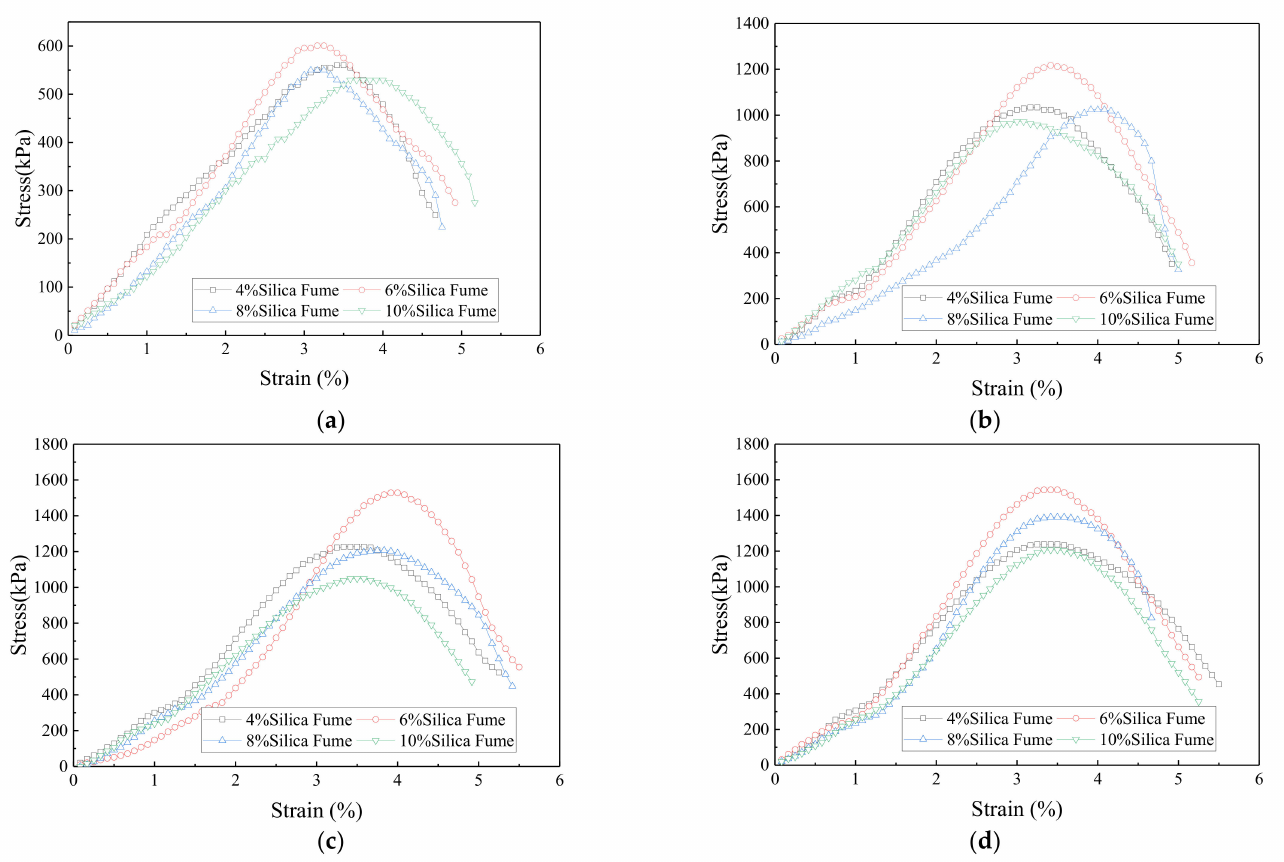
Figure 8. Stress–strain relationship of stabilized soil samples with different silica fume contents for different curing time: ( a ) 3d; ( b ) 7d; ( c ) 14d; ( d ) 28d.